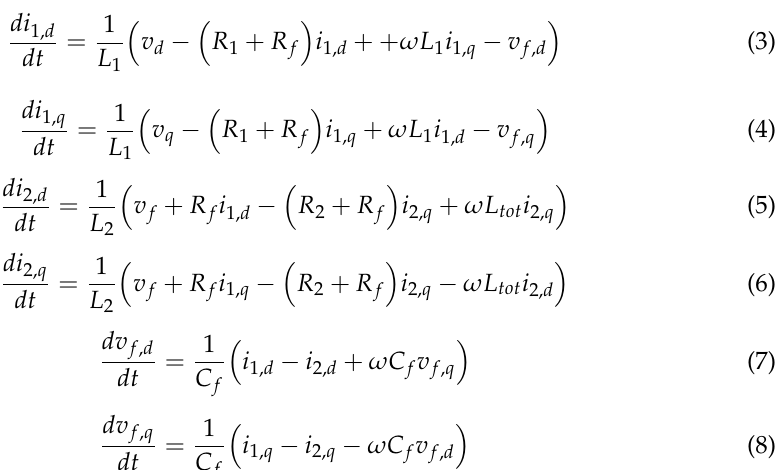
Figure 5. Active and reactive power under nominal model: ( a ) DG1; ( b ) DG2.